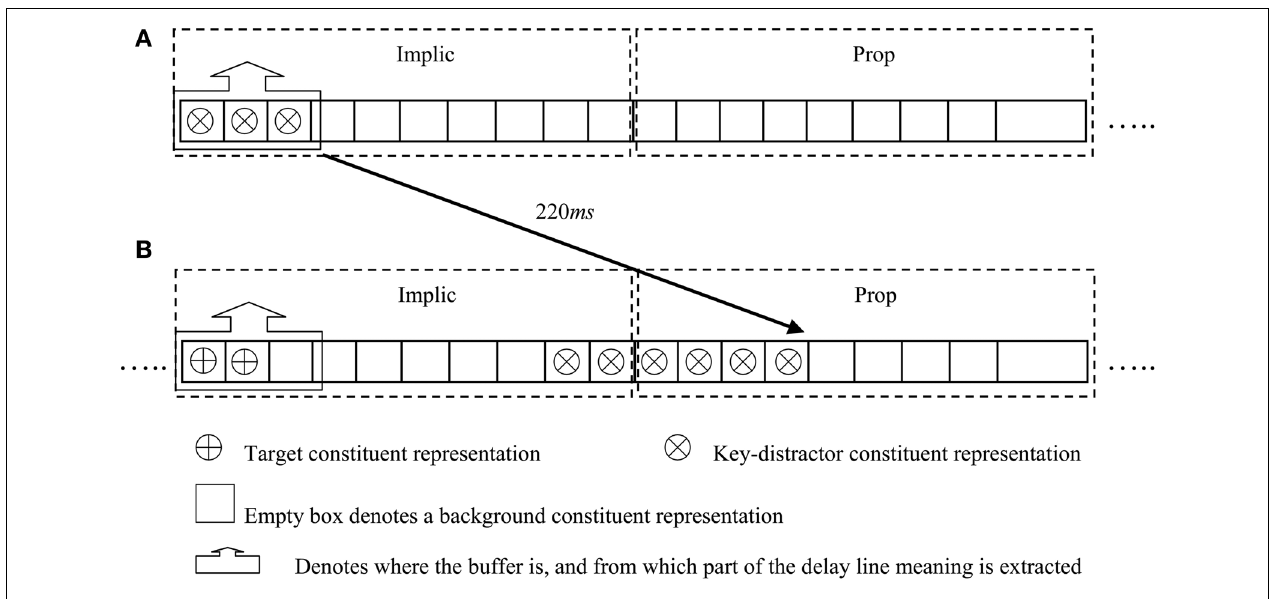
FIGUREA3 | Snapshots of the delay-line when (A) Implic decides to move the buffer to Prop after it has processed the first three constituent representations of the key-distractor; (B) the first two constituent representations of the lag-2 item (target) have entered Implic.